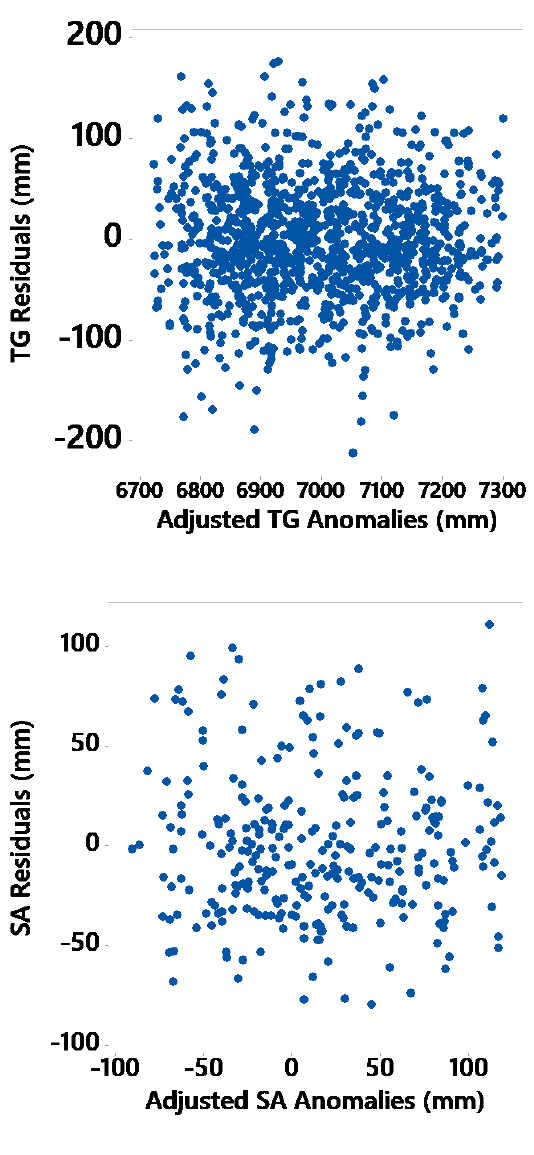
Fig. 4. Atlantic City TG and SA solution residuals plotted against their adjusted records. Circular clusters are indicative of randomly distributed